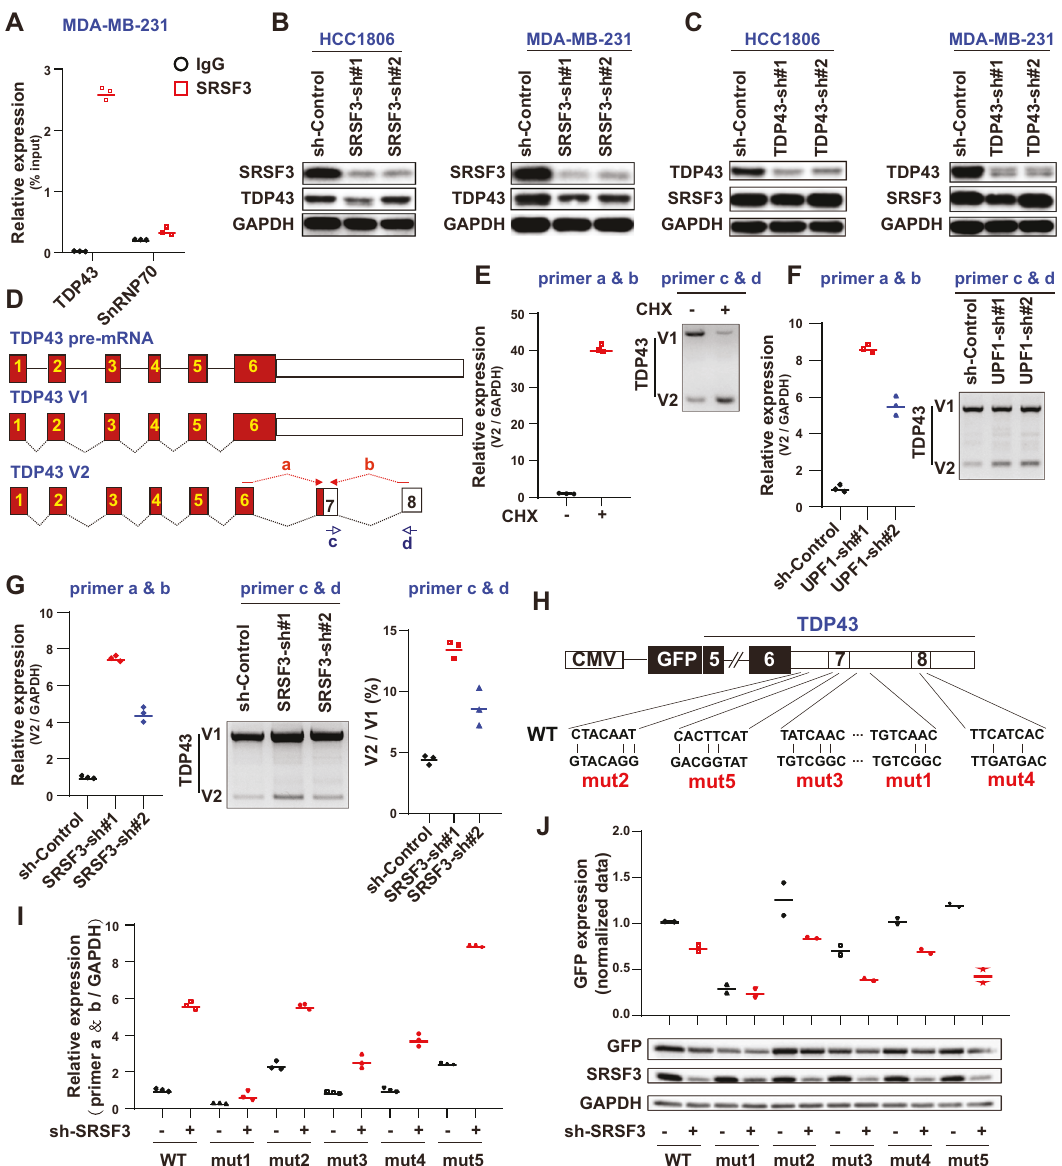
Fig. 5 SRSF3 increases abundance of TDP43 by regulating mRNA nonsense-mediated mRNA decay. A Binding of TDP43 mRNA to SRSF3 proteins detected by RIPA in MDA-MB-231 cells stably expressing Flag (control) or Flag-SRSF3. B Protein levels of TDP43 examined by western blot analysis after SRSF3 KD. C Western blot analysis of SRSF3 protein levels after TDP43 KD. D Schematic of TDP43 pre-mRNA splicing. qPCR primers a and b; semi-quantitative RT-PCR primers c and d spanning the V2 isoform junction. V2 isoform was detected by indicated primers upon treatment with CHX ( E ), sh-UPF1 ( F ), or sh-SRSF3 ( G ) in MDA-MB231 cells. H Schematic of splicing reporter containing GFP gene fused with TDP43 mRNA 3 ’ UTR. Mutations of potential SRSF3 binding sites were introduced as indicated below. I qPCR results in MDA-MB-231 cells with transfected GFP reporter. J Western blotting of GFP protein upon SRSF3 KD. Data are means ±